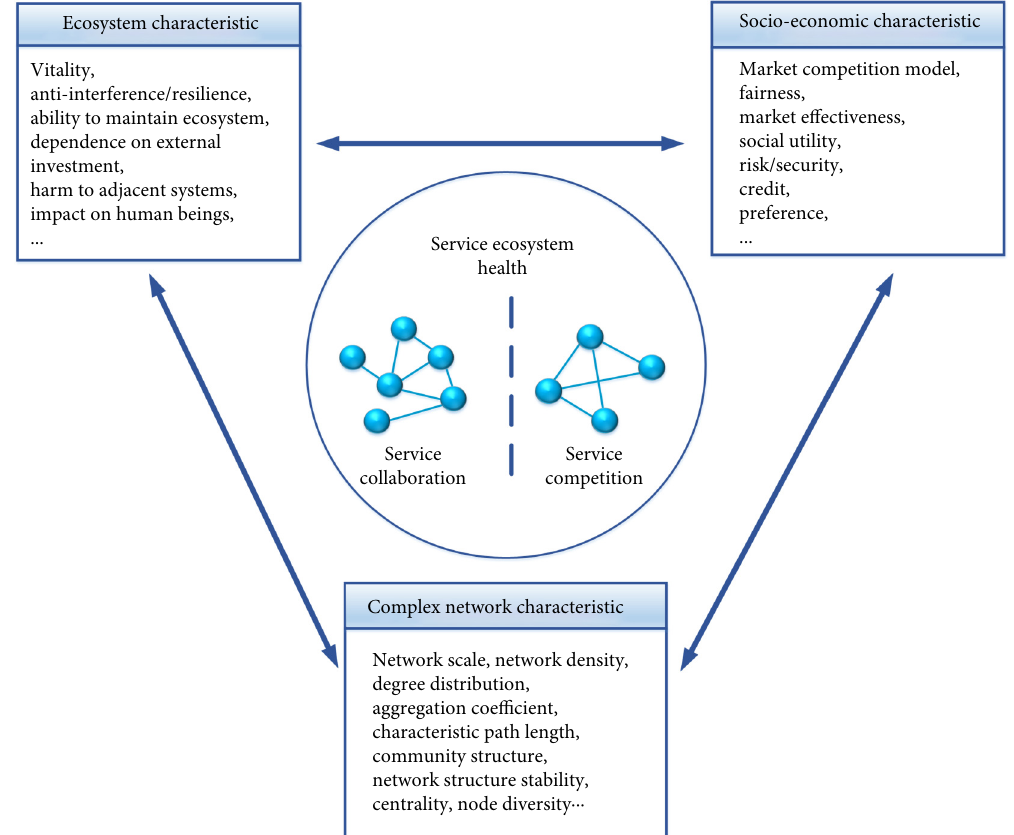
Fig. 8 Status model of the service